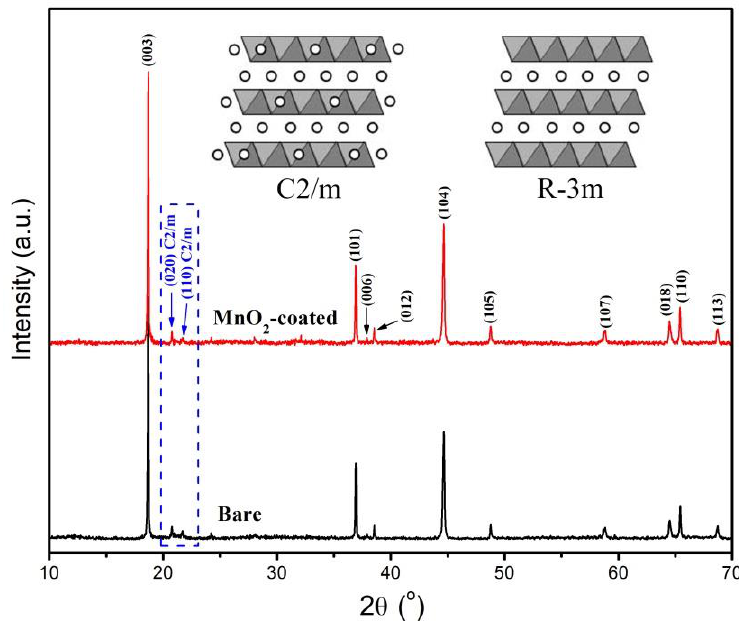
Figure 1. XRD results of bare and MnO 2 -coated LTMO. Table 1. Lattice parameters of the LTMO before and after the MnO 2